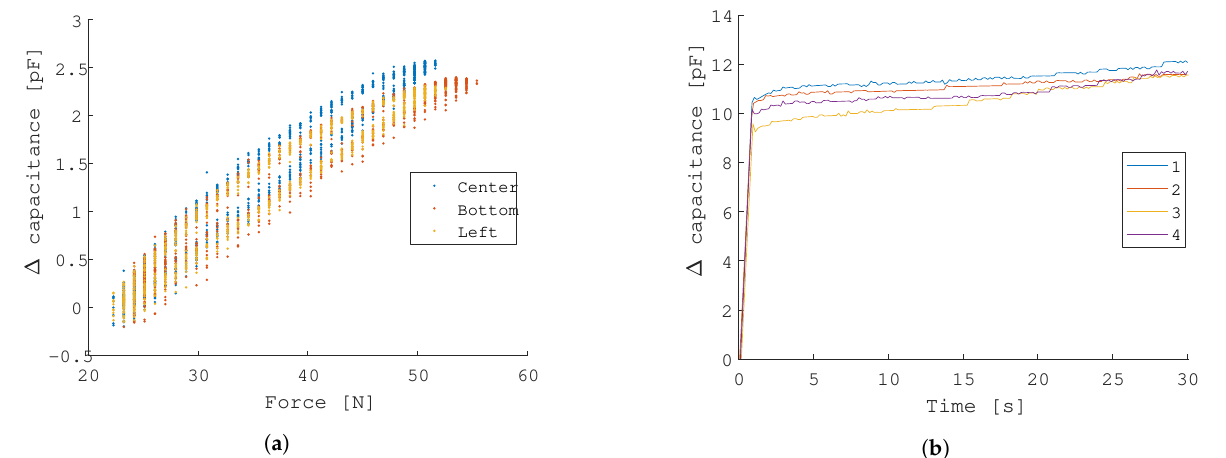
Figure 9. Test-bench characterization results (C): the response of the sensor when subjected to loads at different locations and the repeatability of the sensor is assessed. ( a ) Effects of indenting the sensor at three different locations (center, bottom, and left). ( b ) Repeatability of a single sensor under a constant load of 10 N.